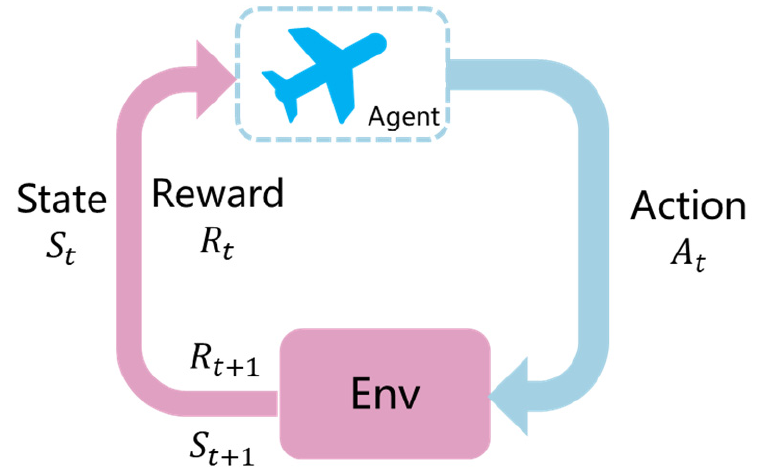
Figure 4. The basic process of reinforcement learning.